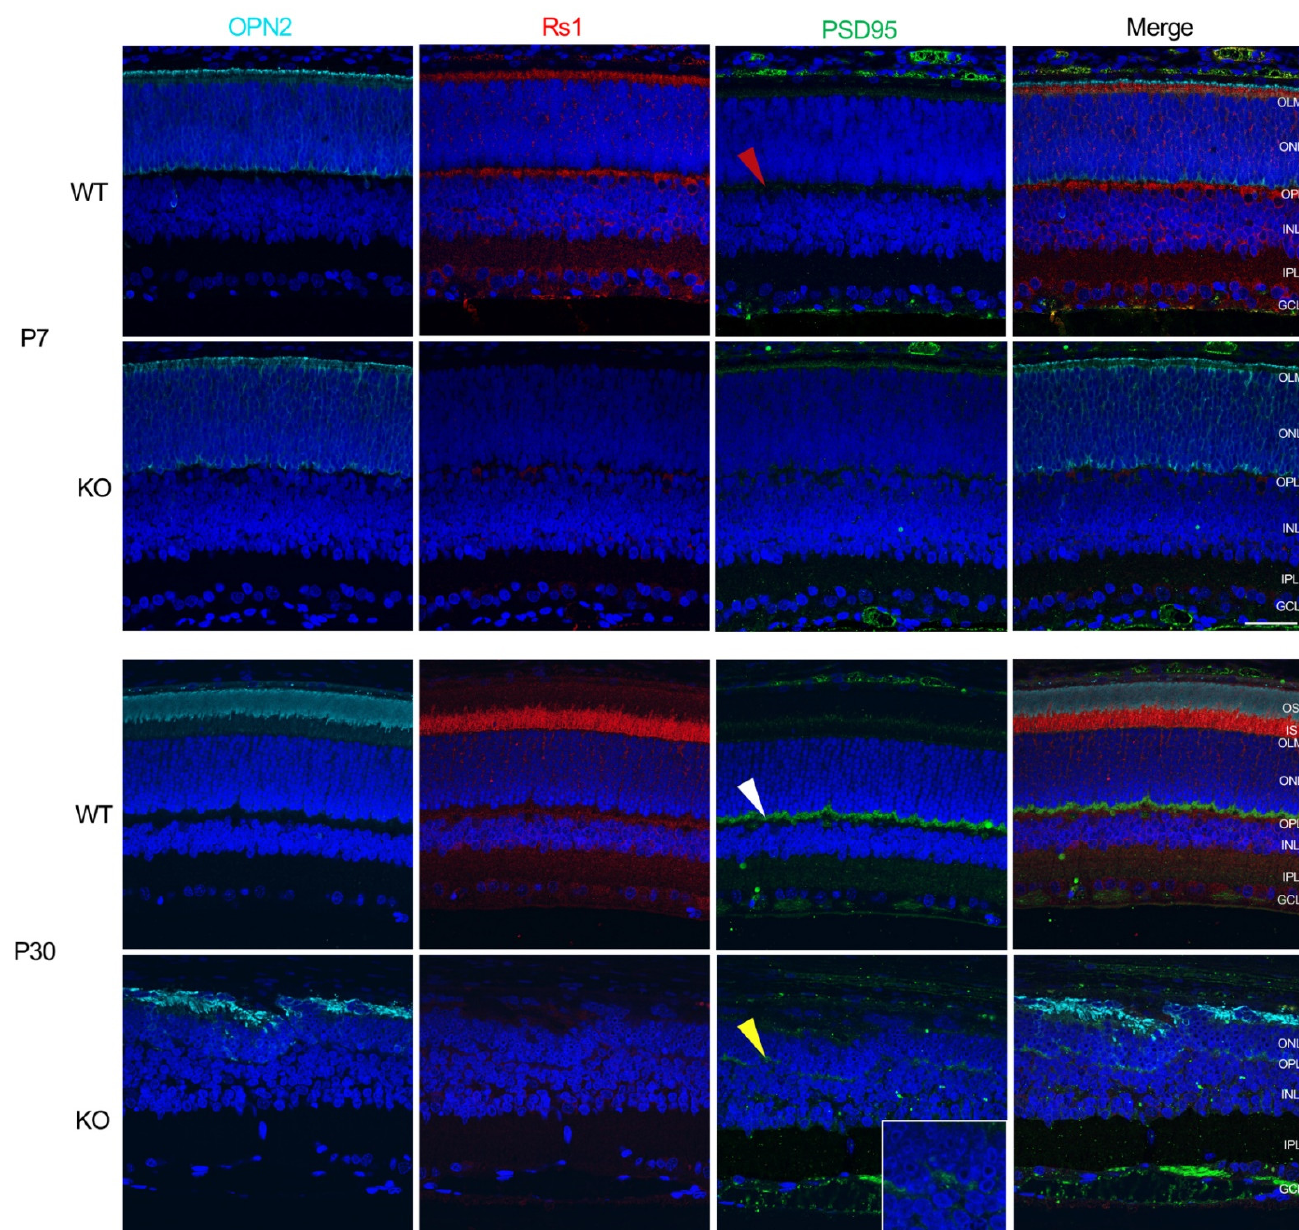
Figure 5. Photoreceptors and synapse immunolabeling in Rs1 -/Y rat retina. Immunolabeling of WT and KO retinas for rhodopsin (OPN2), retinoschisin (Rs1), and post-synaptic density marker (PSD95) at P7 and P30 time points. Antibody labeling of OPN2 (cyan) in the outer segments of rod photoreceptor, Rs1 (red) in the inner retinal cells, and PSD95 (green) in presynaptic terminals of photoreceptors. At P7, no abnormal features were observed in the KO retina, and Rs1 is not present. PSD95 was minimally present in the WT or KO retina at P7 ( red arrowheads ), while rhodopsin was present and orderly in both. At P30, the WT retina showed normal maturity, organization of retinal layers, and protein expression of OPN2, Rs1, and PSD95 ( white arrowhead ). The KO retina showed disruption in normal development in the absence of Rs1. Rhodopsin signaling was delocalized, and the PSD95 signal was reduced at the synaptic terminals ( yellow arrowhead ). Scale bar = 40 μm.